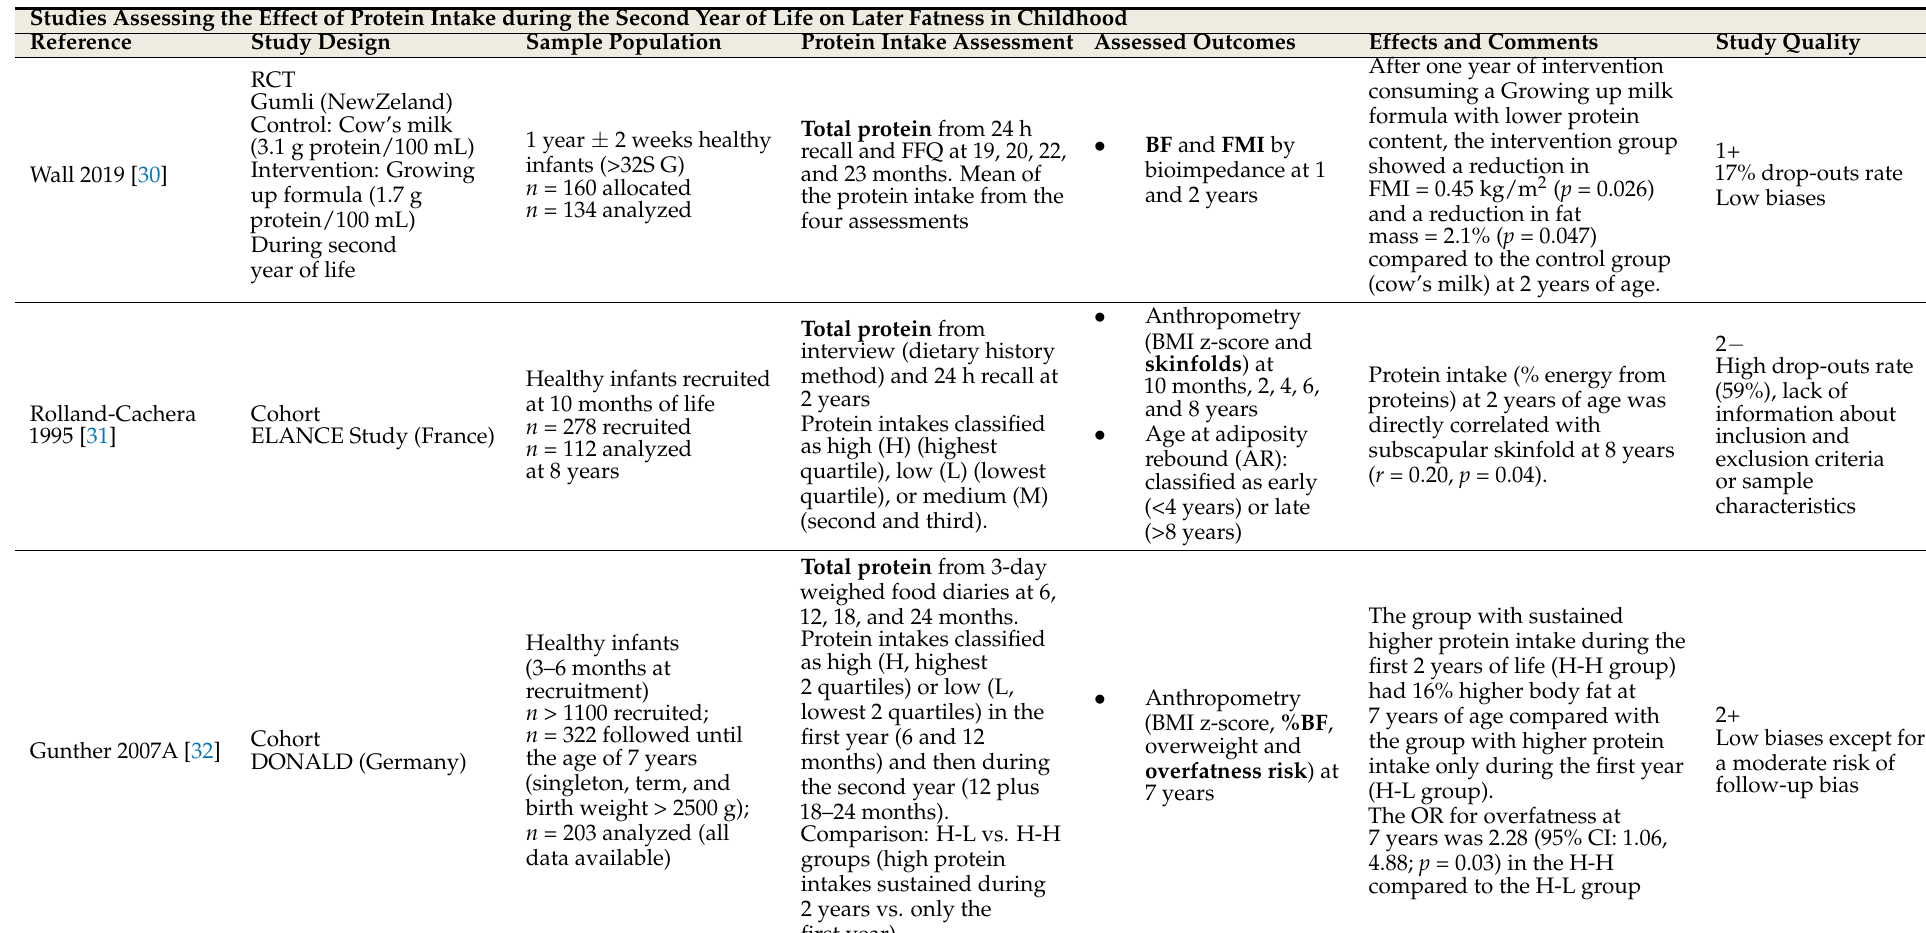
Table 1. Included studies grouped by assessed